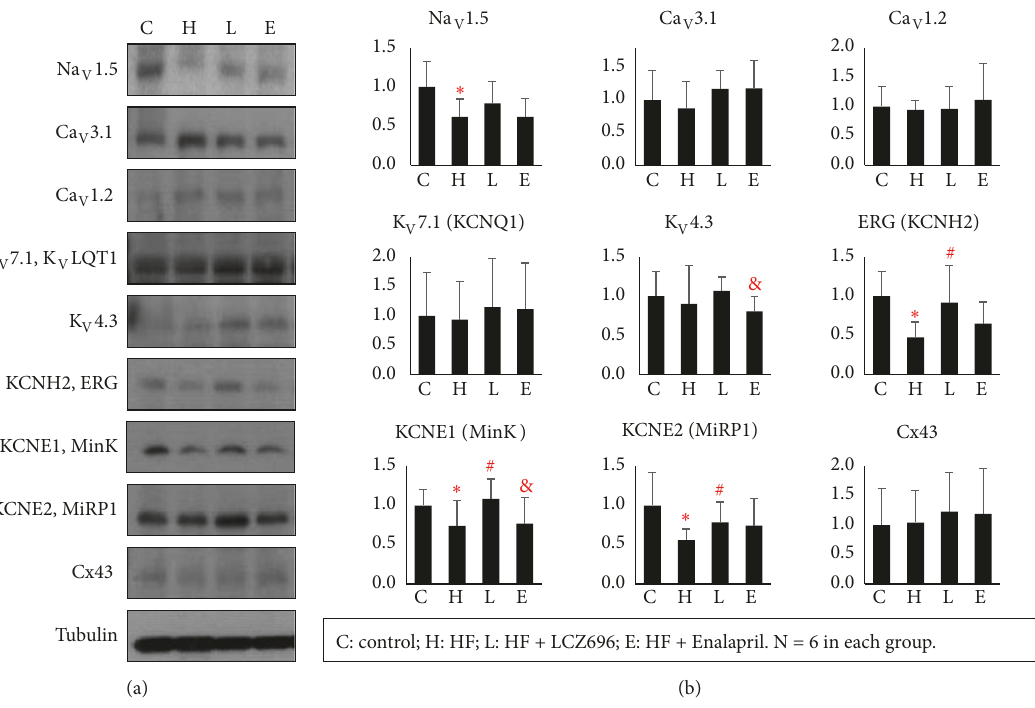
Figure 4: Results of protein analyses. (a) Representative examples of channel proteins. (b) Summarized results of channel proteins. Groups abbreviations:S, Sham; V, vehicle;L, LCZ696; E enalapril. N = 6 for all groups. ∗ indicatesP < 0.05 in the comparison between the sham group and the HF-vehicle group. # indicates P < 0.05 in the comparison between the HF-vehicle group and the HF-LCZ696 group. & indicates P < 0.05 in the comparison between the HF-vehicle group and the HF-LCZ696